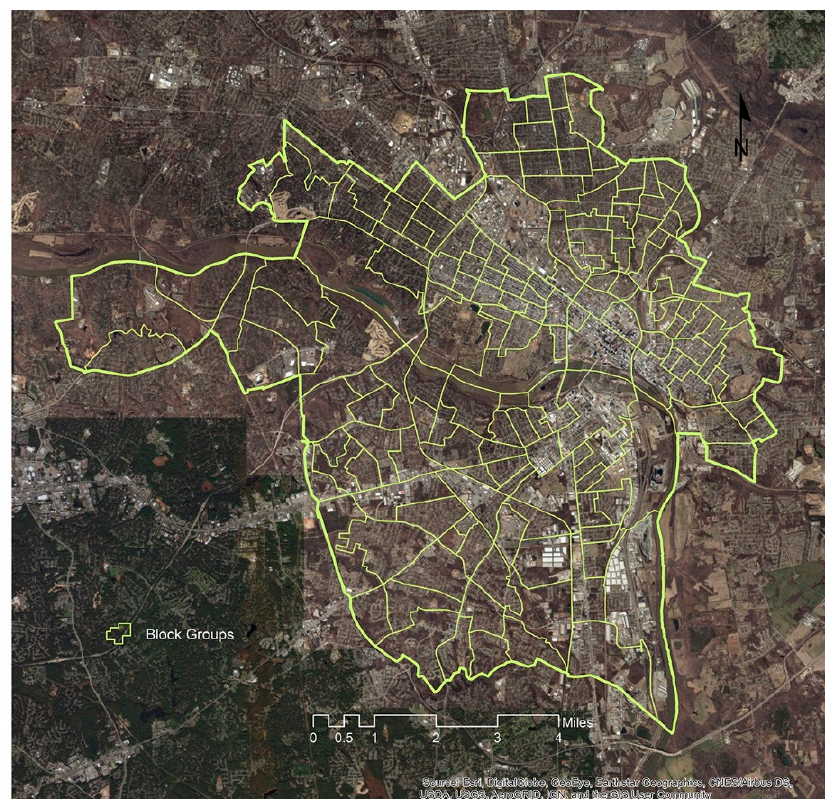
Figure 4. Study area imagery and the 161 Census Block Groups—City of Richmond, Virginia (Sources: US Census, ESRI (Environmental Systems Research Institute), DigitalGlobe, GeoEye, Earthstar Geographics, CNES (Centre national d'études spatiales)/Airbus DS (Defense and Space), USDA (U.S. Dept. of Agriculture), USGS (U.S. Geological Survey), AeroGRID, IGN (Institut géographique national), and the GIS (Geographic Information System) User Community).